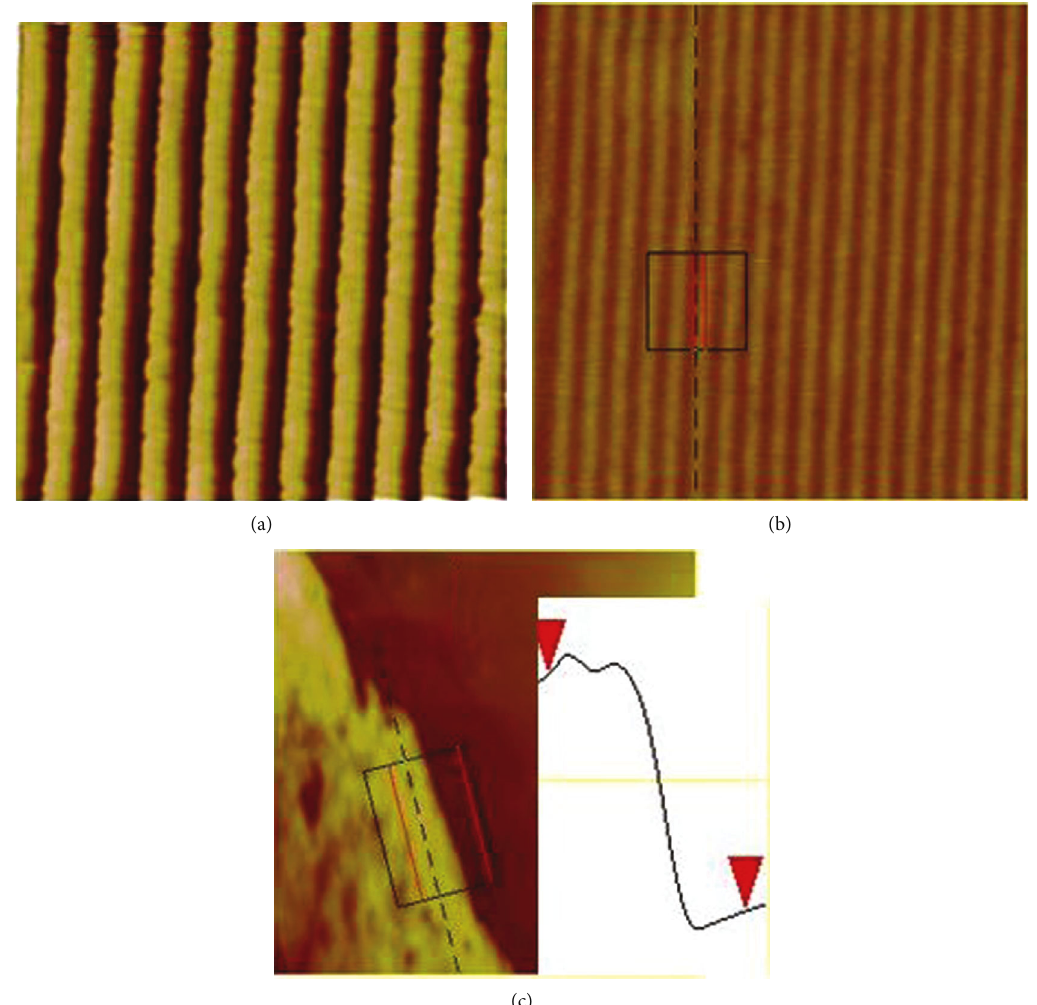
Figure 11: (a) Atomic force microscopy image of PNIPAM brush structure 25 ° C; (b) at 36 ° C; and (d) atomic microscopy image of a scratched polymer brush with its